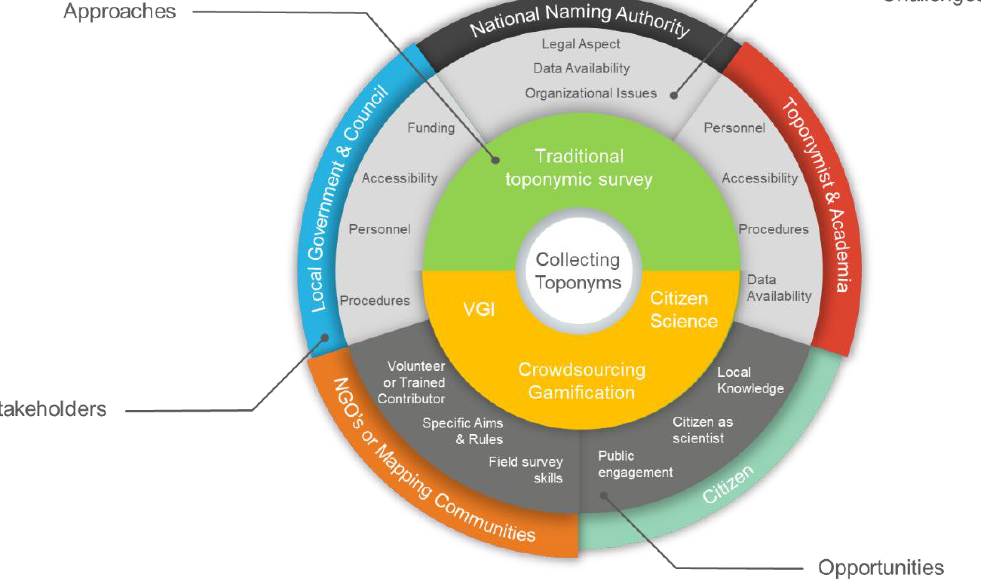
Figure 1. Challenges and opportunities to explore the potential use of a toponym collection approach with multiple stakeholders.